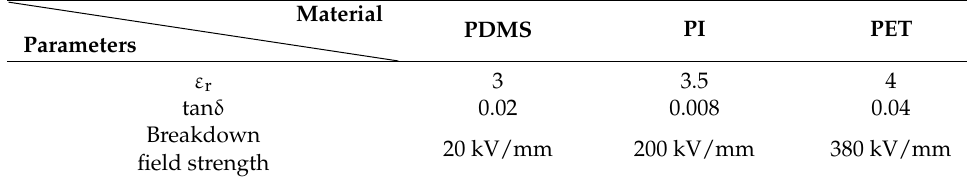
Table 2. Basic parameters of flexible